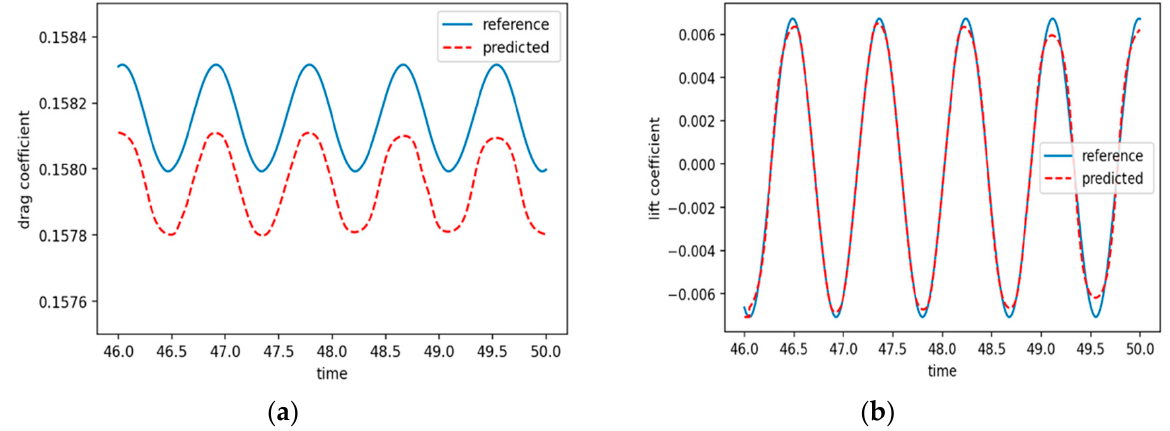
Figure 11. Reference aero force and predicted aero force at Re = 1250: ( a ) drag coe ffi cient; ( b ) lift coe ffi cient.